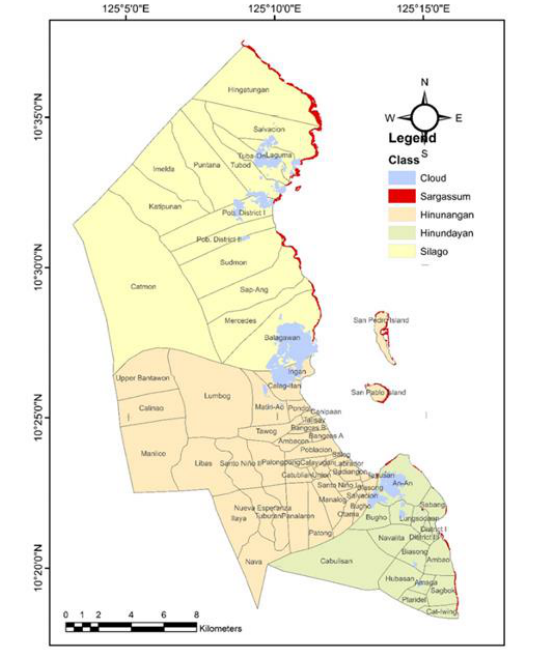
Figure 6. Sargassum map from classification of Sentinel 2 December